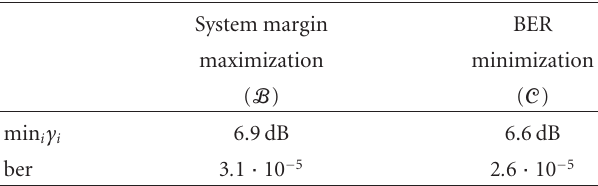
Table 1: Example of system margin and BER with n = 20, R = 100, psdnr = 25dB, and β =